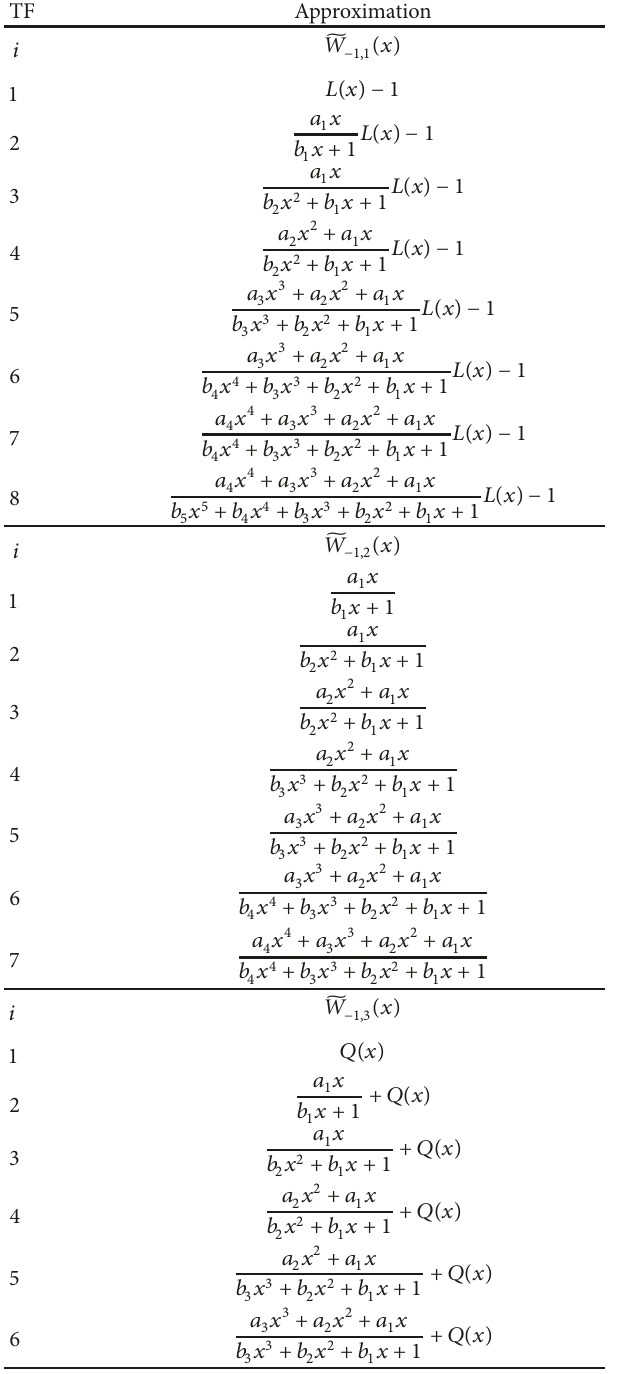
̃𝑊 (𝑥) , ̃𝑊 (𝑥) 0,1 0,2